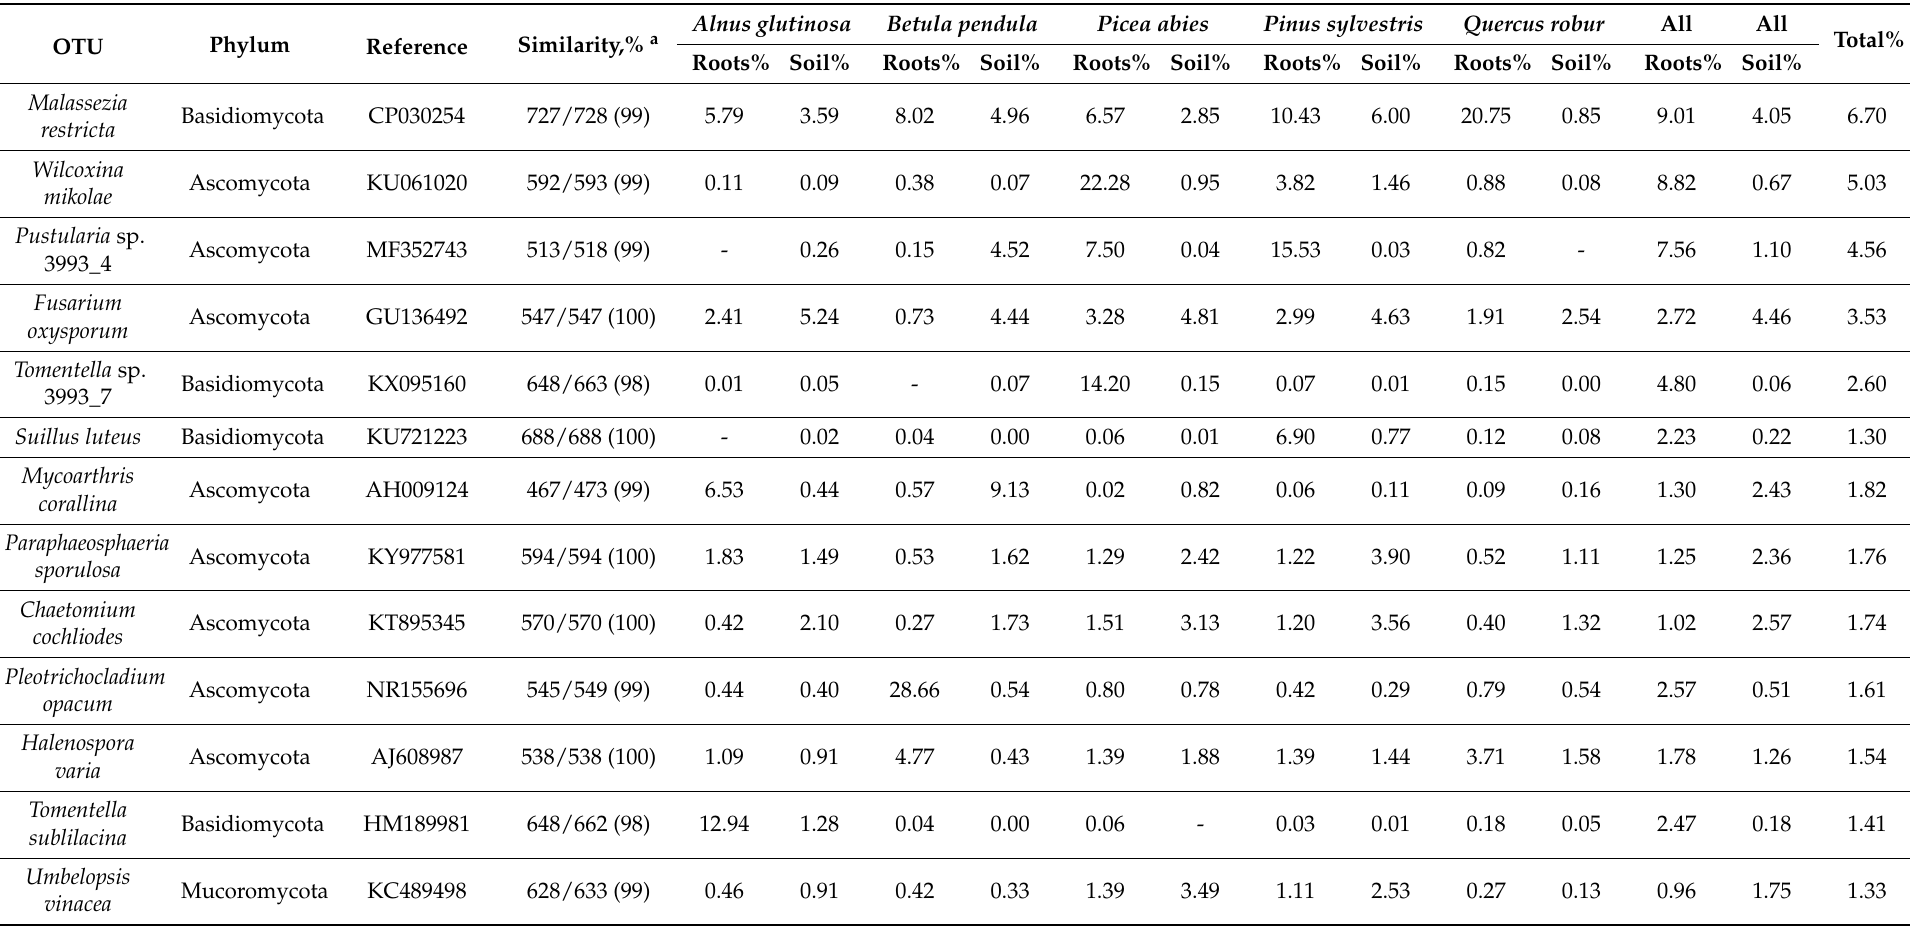
Table 3. Occurrence and relative abundance of the 30 most common fungal OTUs (show as a proportion of all of the high-quality fungal sequences) in the roots and soil of the five tree species that were bare-root cultivated in the forest nurseries. The data from the different forest nurseries are